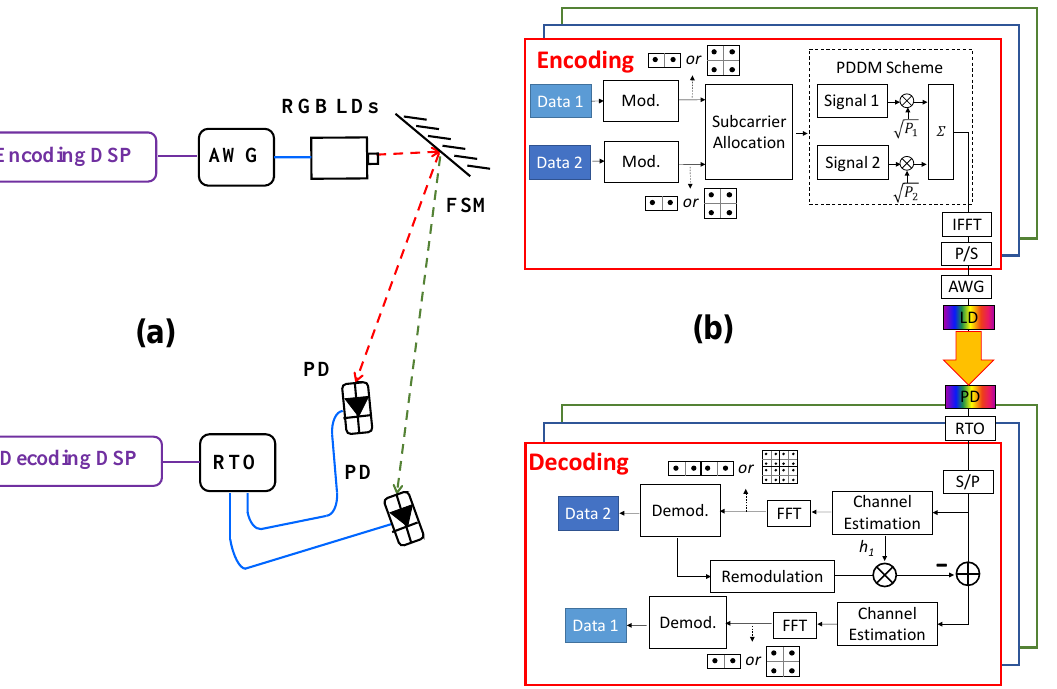
Figure 1. ( a ) Architecture of the RGB VLC systems using OFDM-NOMA. ( b ) Flow diagram and experimental setup of the proposed OFDM-NOMA VLC system using RGB LDs. IFFT: inverted fast-Fourier transform; P/S: parallel to serial; AWG: arbitrary waveform generator; S/P: serial to parallel. LD: laser diode; FSM: fast steering mirror; PD: photodiode; RTO: real time oscilloscope.